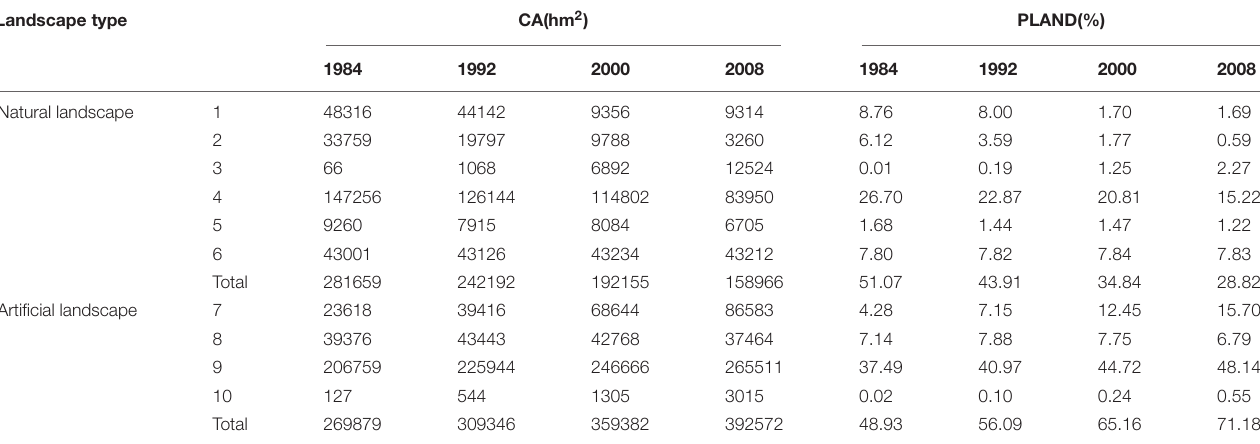
TABLE 1 | Area statistic of landscape types in Yancheng coast.